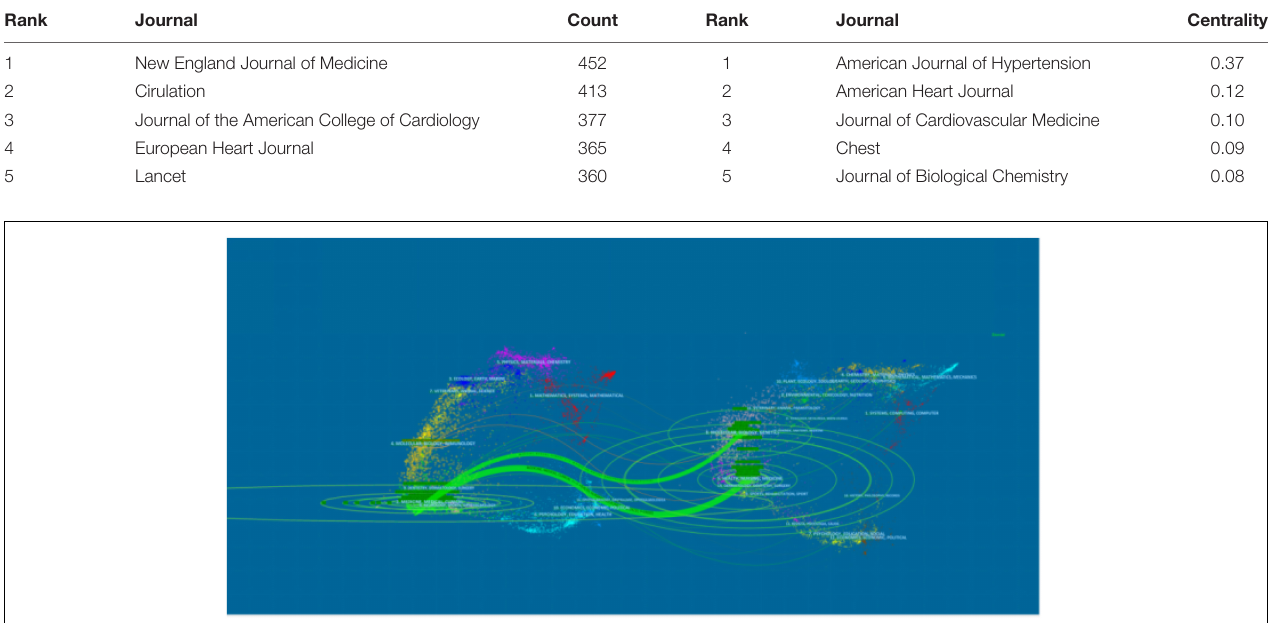
TABLE 5 | The top 5 core and the top five centrality journals on ARNI study in the cardiovascular system.